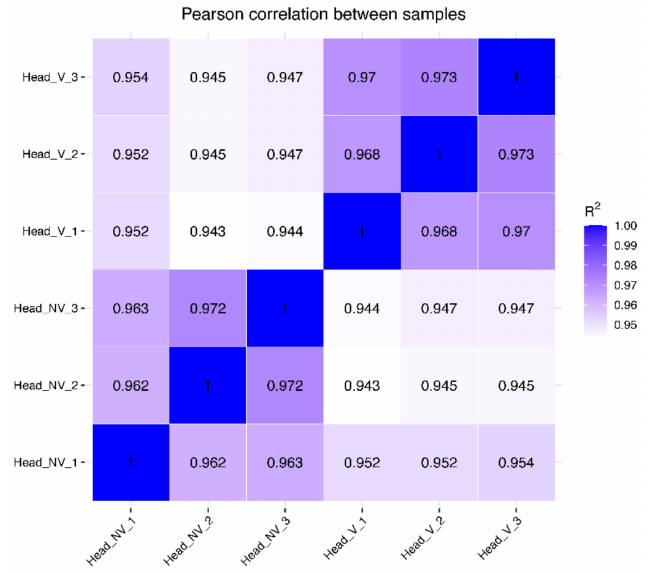
Figure 2. Pearson correlations of gene expression levels (FPKM) of the six SBPH samples.